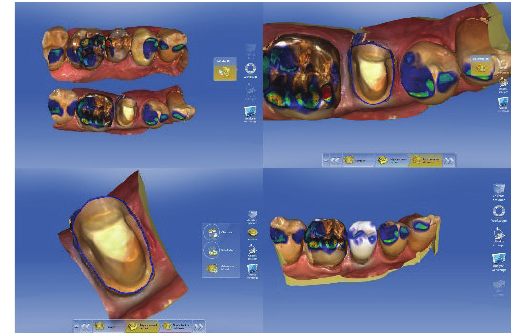
Figure 4: Intraoral scans with marked preparation line and design suggestion generated with the CEREC software (version 4.2).